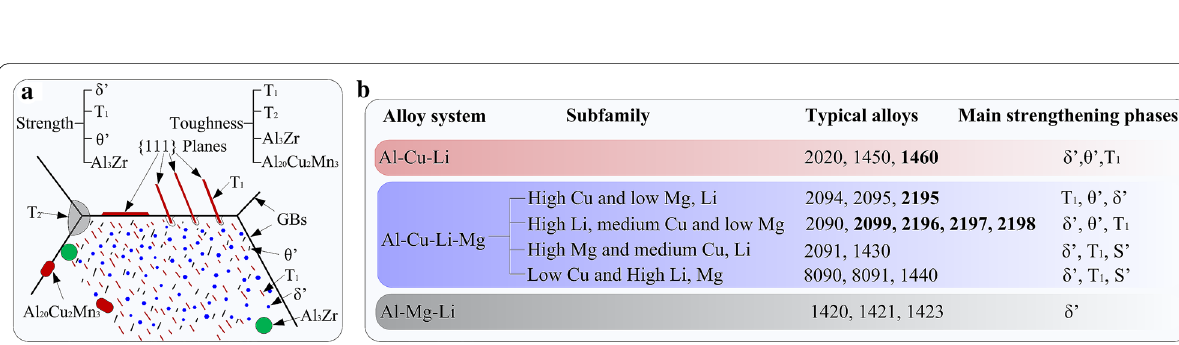
Figure 14 a Precipitates microstructure in 3rd generation Al–Li alloys (Redraw based on reference [3]) and b main strengthening phases in different alloy